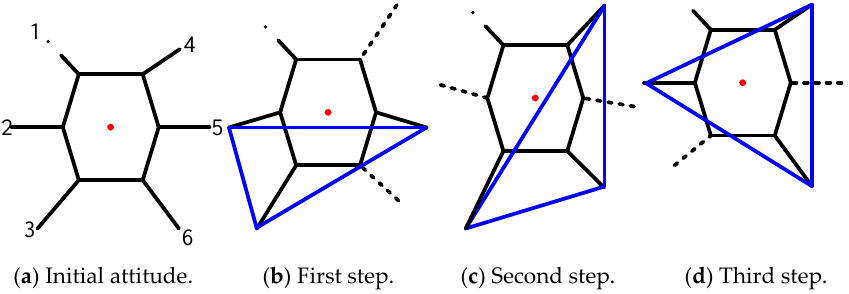
Figure 6. Transfer order of legs in fault tolerant tripod gait in leg 1 fault state.